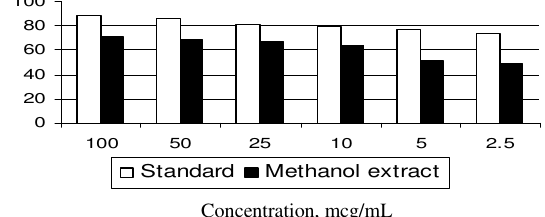
Figure 4. Metal chelating activity of methanol extract of E. cirrhatum Total phenol content was expressed in terms of milligram tannic acid equivalents